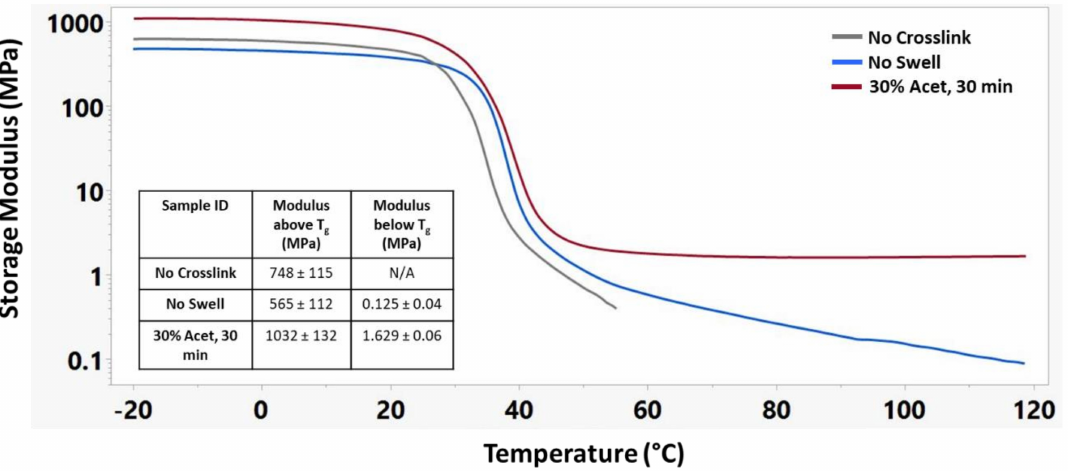
Figure 6. Representative storage modulus curves of different crosslinking treatments along with corresponding modulus above and below T g. n = 3 for each sample